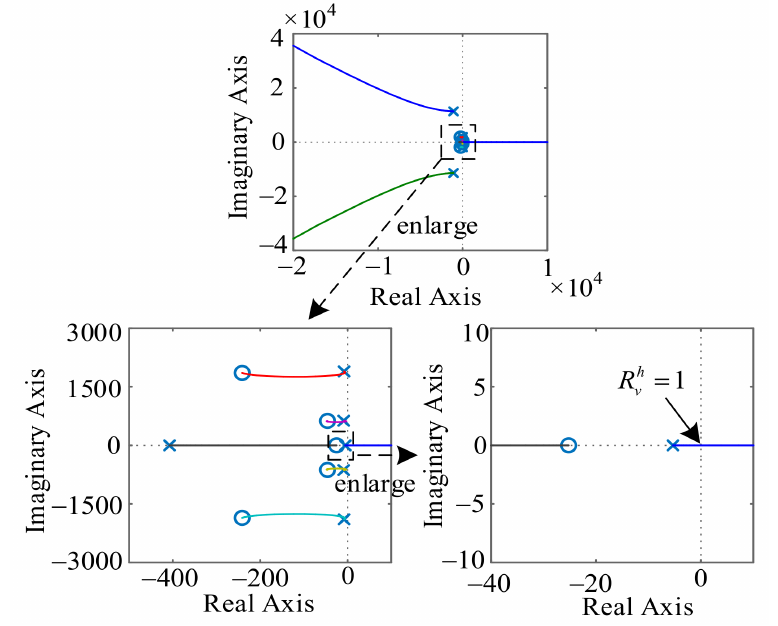
Figure 6. Root locus of